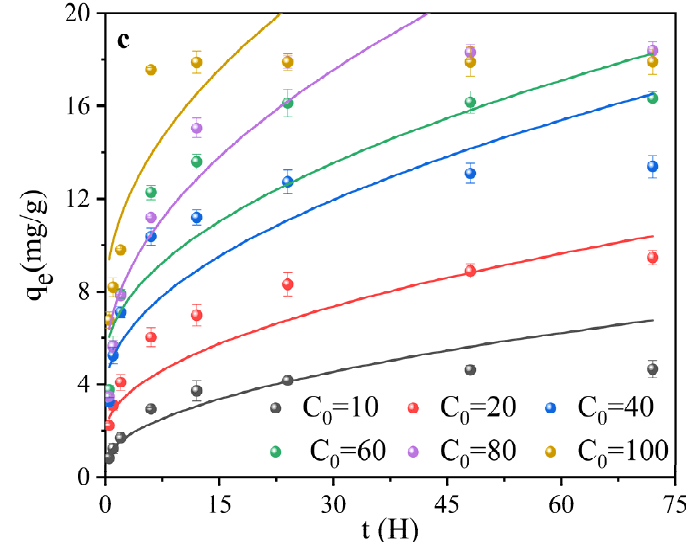
Figure 8. Fitting of the pseudo-first-order adsorption kinetic curve of MCM-48-SH ( a ); fitting of the pseudo-second-order adsorption kinetic curve of MCM-48-SH ( b ); fitting of the intraparticle diffusion model of MCM-48-SH ( c ); (the reaction temperature was 25 °C, the amount of adsorbent was 25 mg, the pH of the solution was 2, and the reaction time was 3 d).